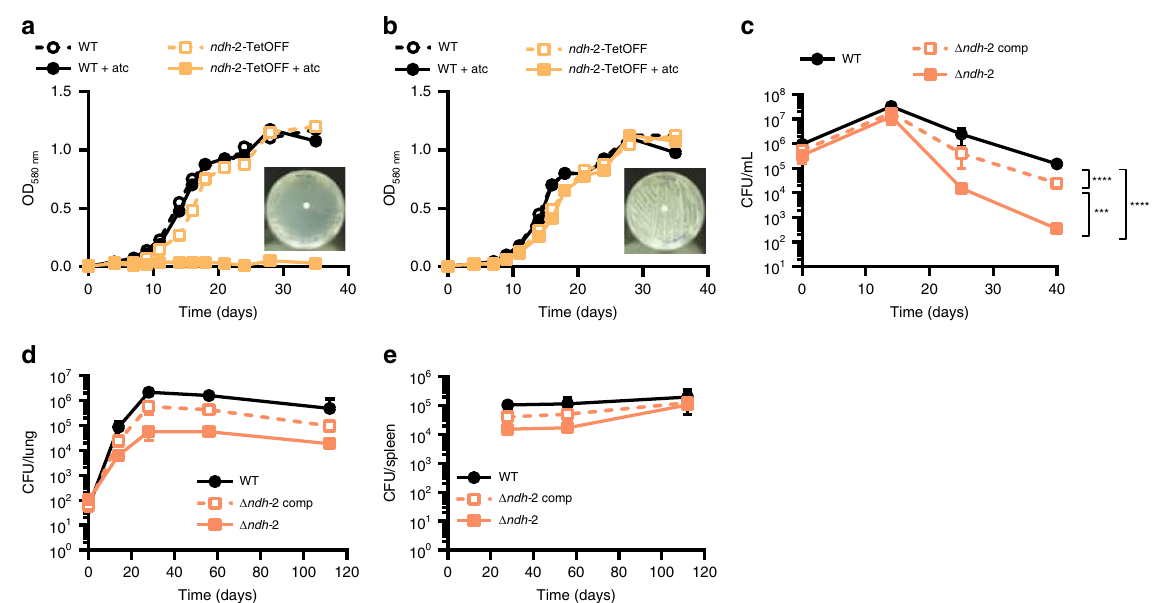
Fig. 4 NDH-2 is essential for growth with fatty acids. Growth with ( a ) or without fatty acids ( b ). Data are representative of two independent experiments. c Growth and survival in the Wayne model of hypoxia. Data are averages of six to eight data points from two independent experiments. Growth and persistence in lungs ( d ) and spleens ( e ) of C57BL/6 mice. Data are averages from four mice per time point and representative of two independent infections. Error bars correspond to standard deviation. “ Comp ” stands for complemented. Statistical signi fi cance was assessed by one-way ANOVA followed by post hoc test (Tukey test; GraphPad Prism). Differences between strains in ( d ) and ( e ) are not signi fi cant. *** P < 0.001; **** P < 0.0001. Source data are provided as a Source Data fi